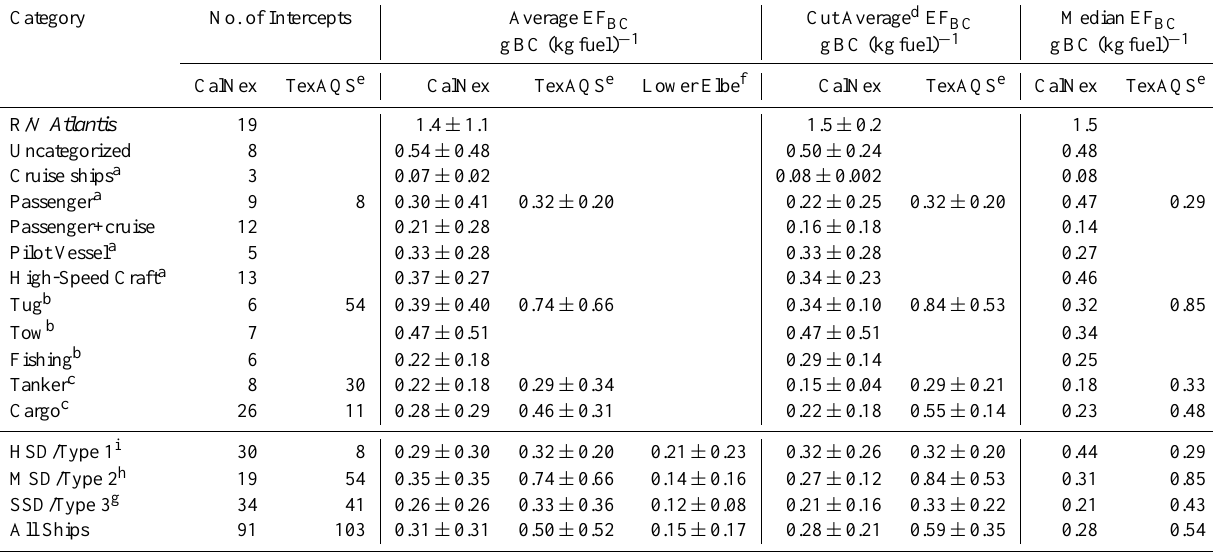
Table 2. Geometric average EF BC values categorized by engine type and AIS vessel type for CalNex and TexAQS, and arithmatic average EF BC values for the lower Elbe study from Diesch et al. (2013). Uncertainties are 1 standard deviation.